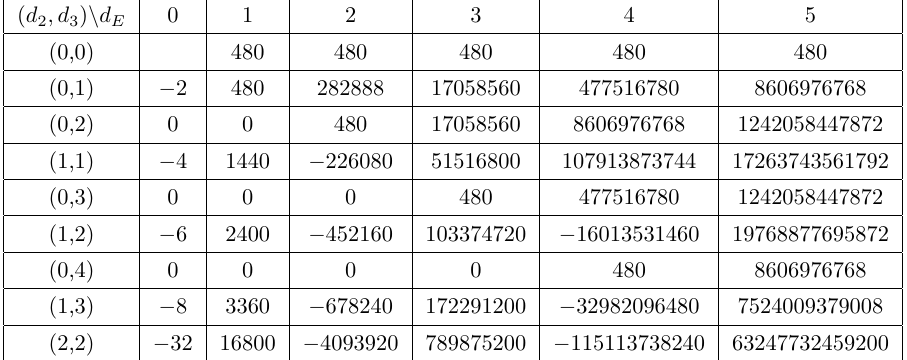
Table 18 . The refined GV numbers n g L ,g R